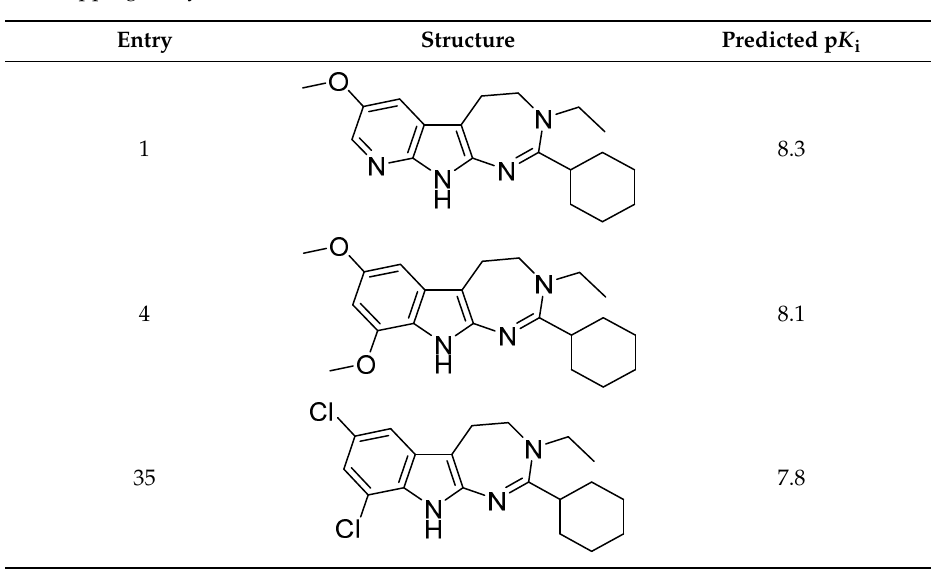
Table 3. Docking calculated σ 2 p K i values compared to the 3D-QSAR predicted ones and docking calculated σ 1 p K i values with σ 1 / σ 2 selectivity index for selected